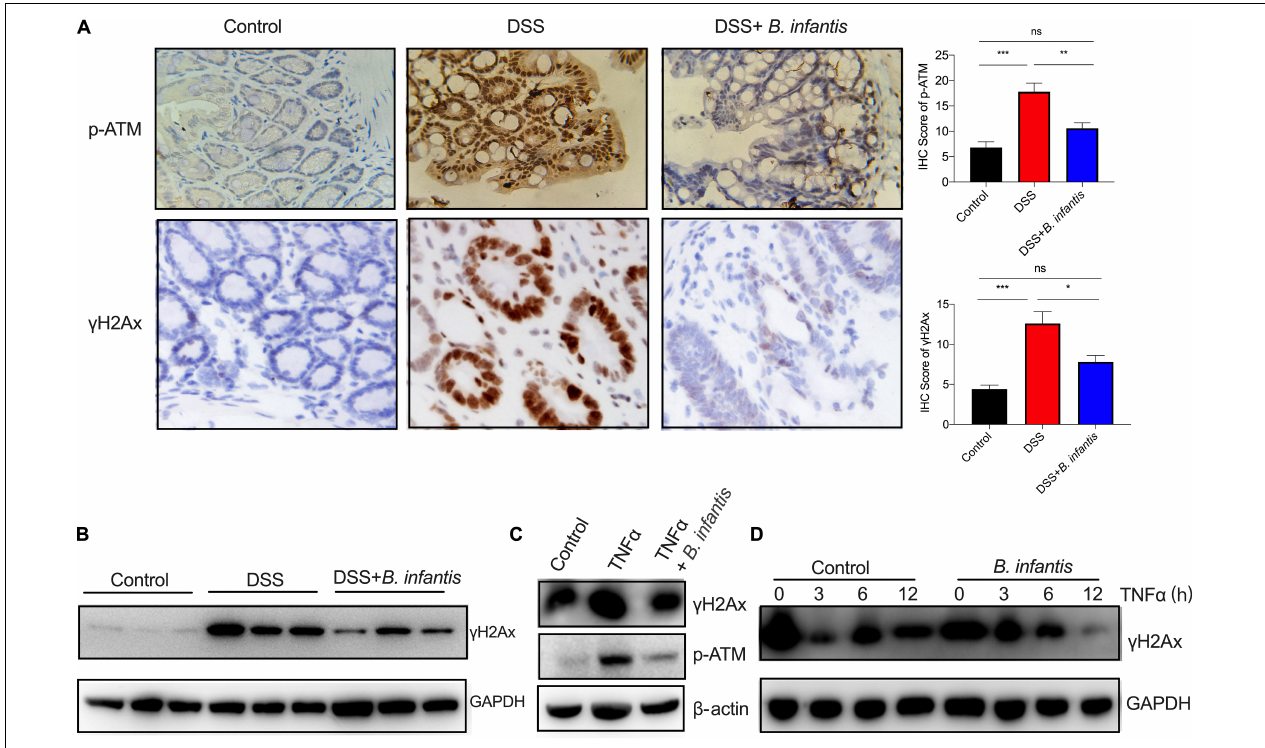
FIGURE 4 | Bifidobacterium infantis protected against genome instability in DSS-induced colitis and TNF α -treated intestinal epithelial cells. γ H2Ax expression and ATM phosphorylation were determined in DSS-induced mice that had been administered with B. infantis , as determined by IHC assays (A) and western blotting (B) , respectively. (Magnification, × 20.) (C) The expression of γ H2Ax was examined in TNF α -treated colon epithelial cells that had been co-cultured with B. infantis . (D) HT29 cells were pretreated with TNF α for 6 h, after which media was replaced with fresh media containing vehicle or B. infantis to allow the cells to recover. Western blotting analysis of phosphorylation of γ H2Ax was performed. * p < 0.05, ** p < 0.01, *** p < 0.001, ns, no